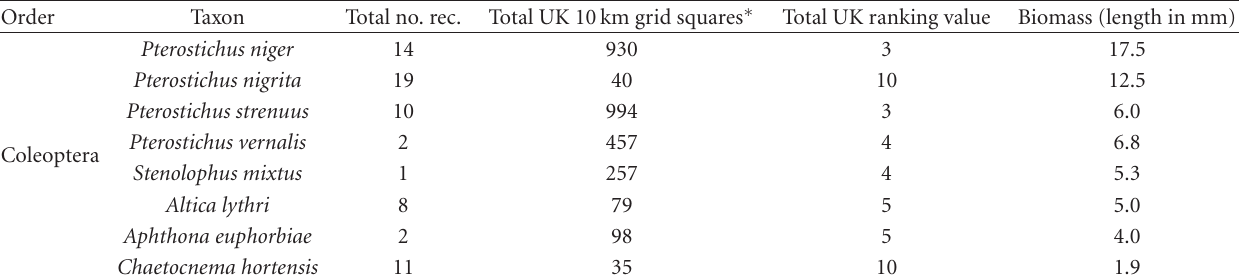
Table 2: Example of species value and biomass ranking applied to part of the coleoptera sample data. Calculation of species value and biomass ranking was completed for all invertebrate species collected, of which a sample of the Coleoptera is shown here. This data was then used to ascertain the diversity of the reed-bed sites.